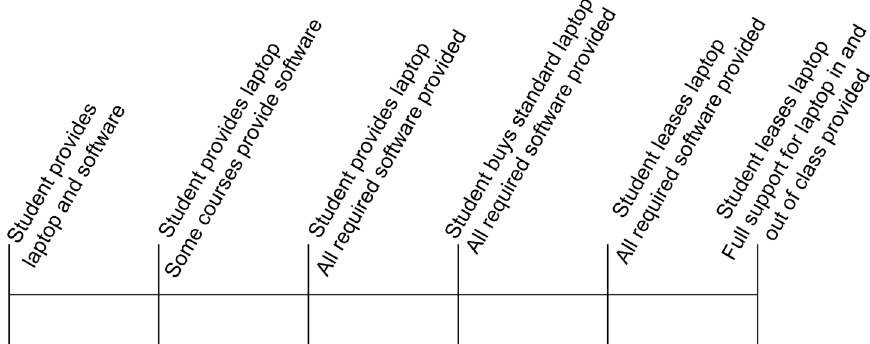
Figure 1. Continuum of laptop learning